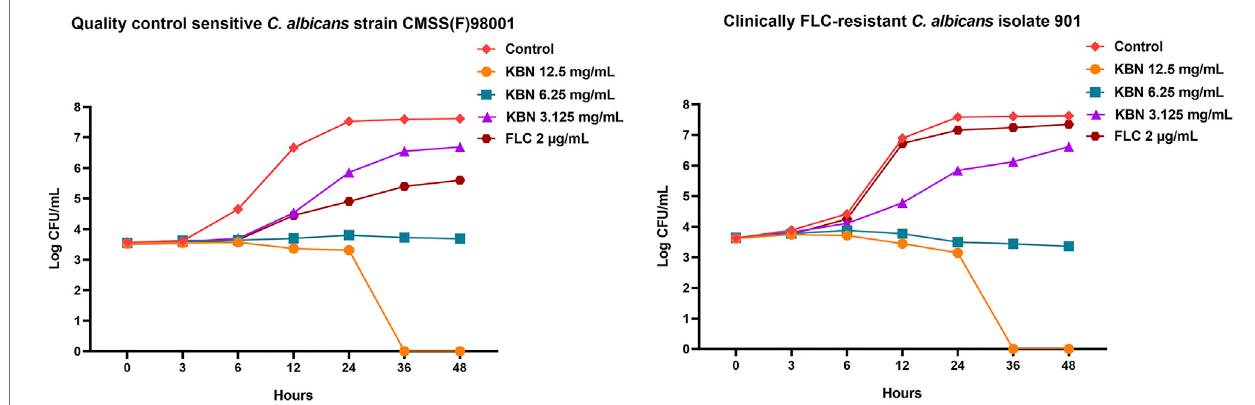
FIGURE2| EffectsofKBNonthetime-killingcurveof C.albicans .Thequality controlsensitive C.albicans strainCMSS(F)98001 andtheclinicallyFLC-resistant C. albicans isolate 901 were used.